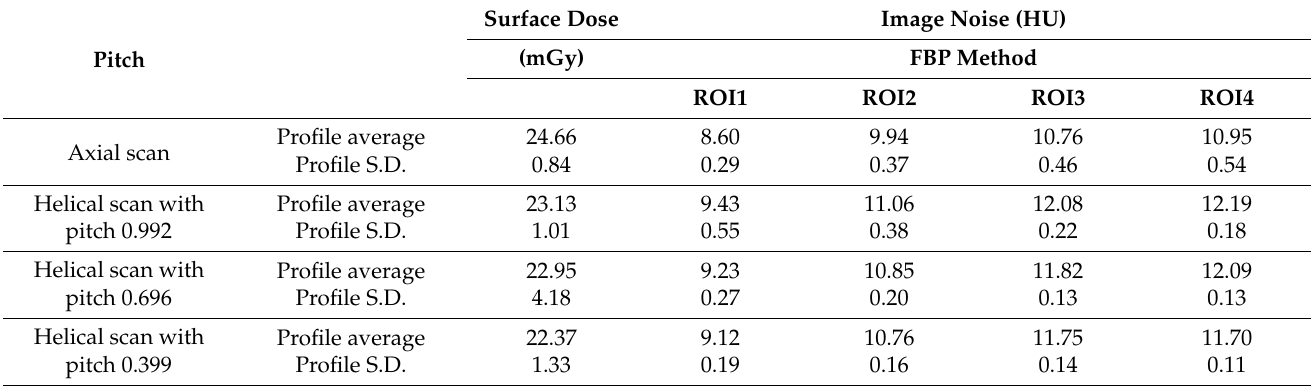
Table A1. ROI2, ROI3, and ROI4 in 256-slice CT for one axial and three helical scans with pitch values of 0.992, 0.696, and 0.399.